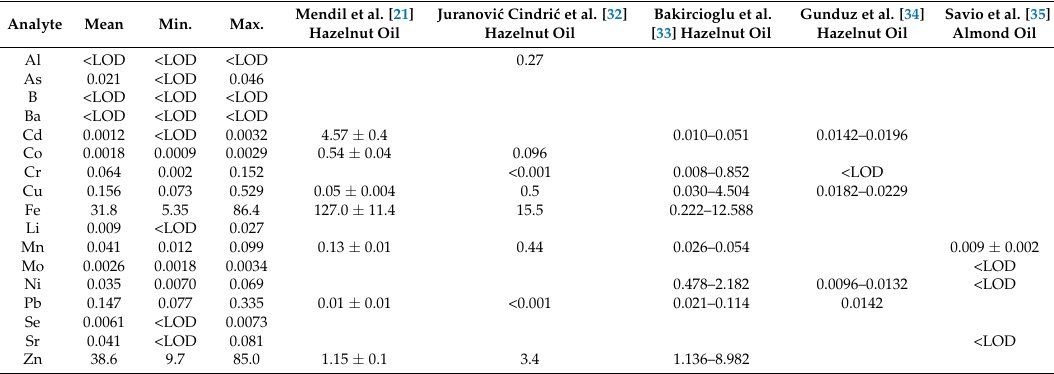
Table 3. The content of elements in walnut oils as compared to literature values for similar oil types